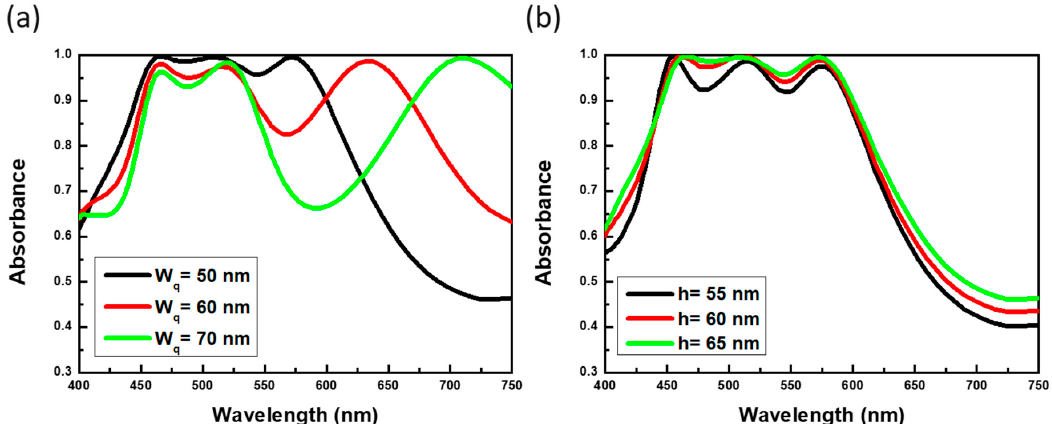
Figure 5. Contributions of varying the ( a ) square widths and ( b ) thickness of the dielectric layer to the absorptance spectra.